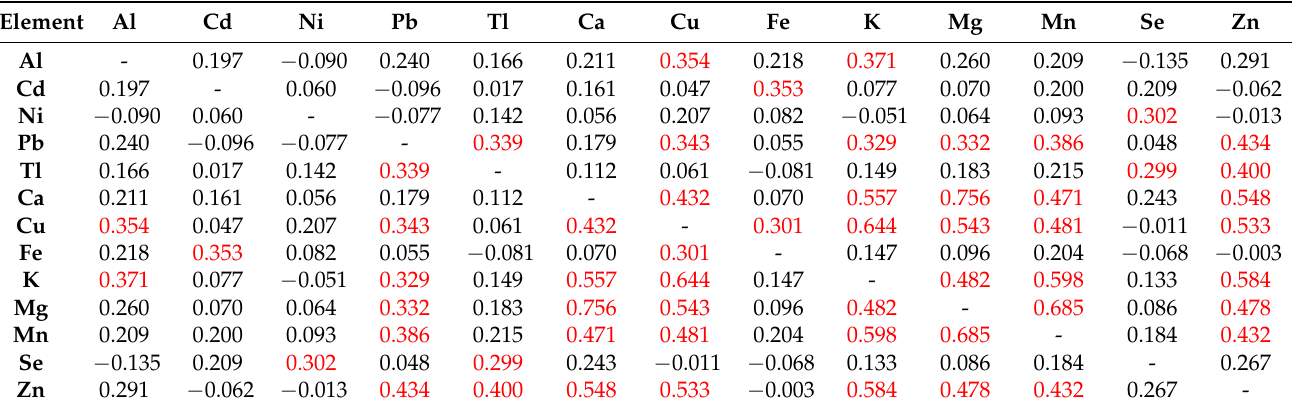
Table 3. Spearman’s rank-order correlations calculated between individual elements’ concentrations in